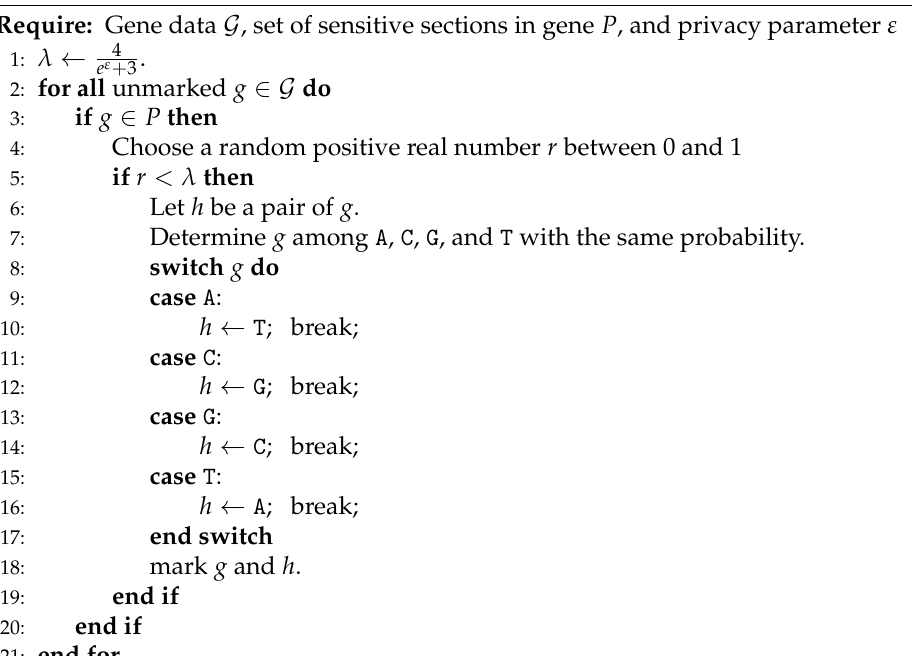
Algorithm 1 Gene Data Modification with